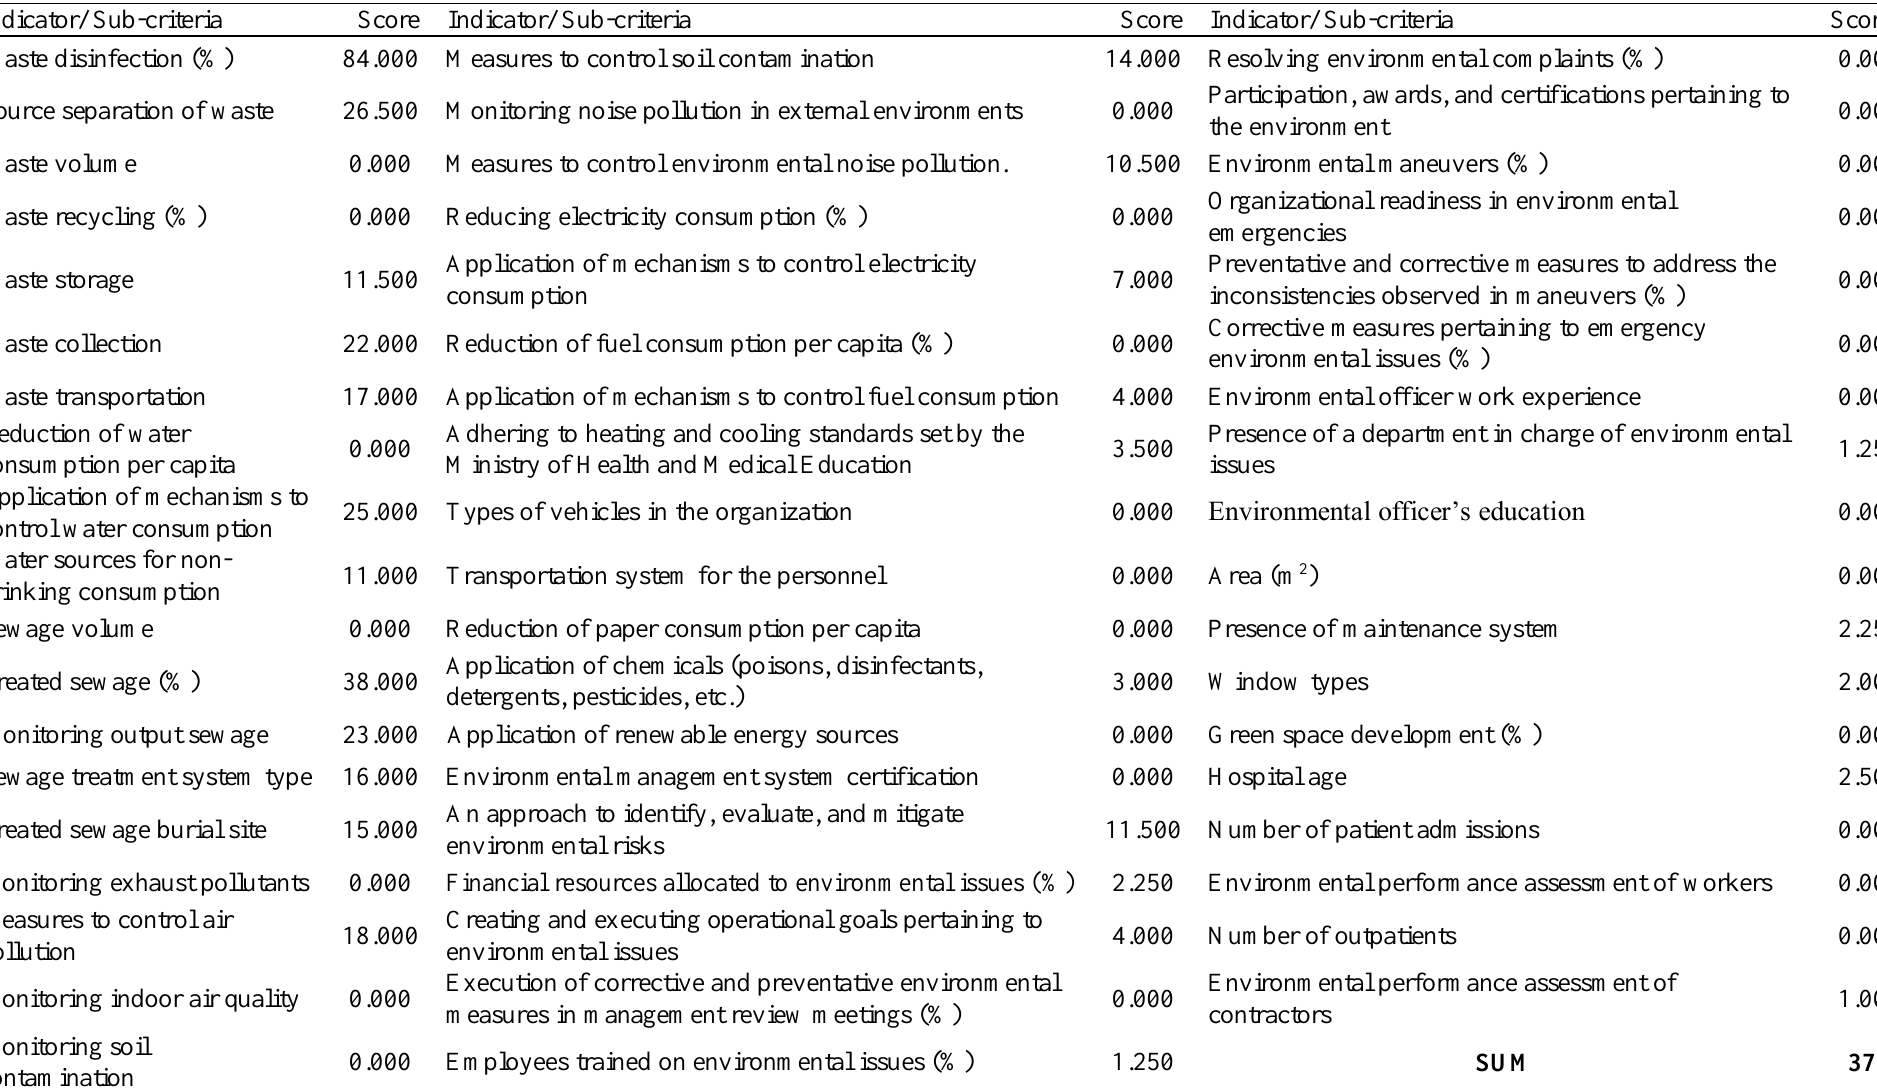
Table 9 . Environmental performance assessment results in Sarem Specialized Hospital